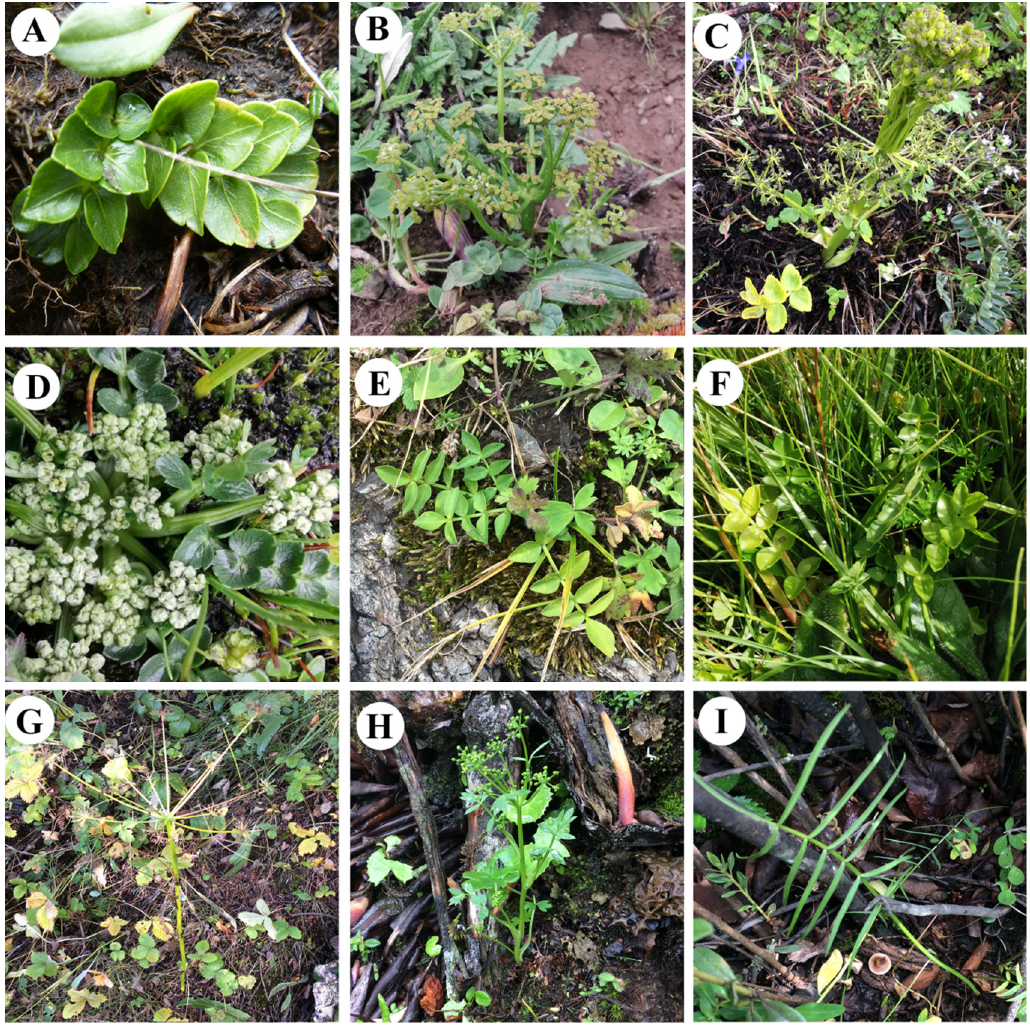
Figure 1. Plants of Chamaesium . ( A ) C. delavayi , ( B ) C. jiulongense , ( C ) C. mallaeanum , ( D ) C. novem-jugum , ( E ) C. paradoxum , ( F ) C. spatuliferum , ( G ) C. thalictrifolium , ( H ) C. viridiflorum , ( I ) C. wolffianum .